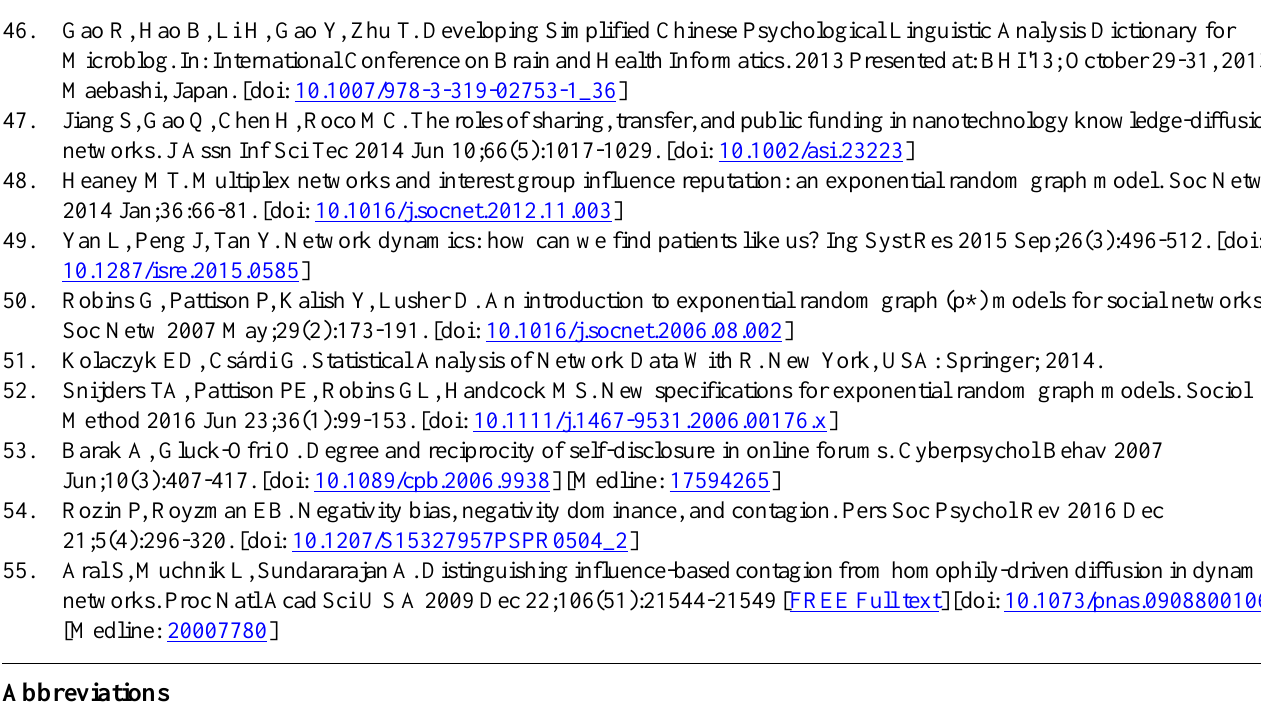
ERGM: exponential random graph